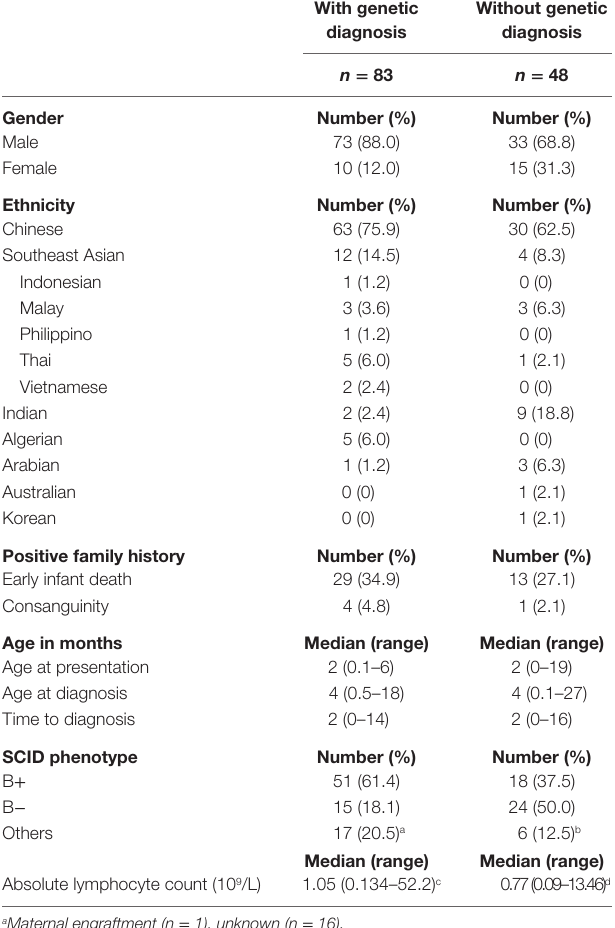
TaBle 2 | Characteristics of patients included in our study ( n = 131) at SCID diagnosis.